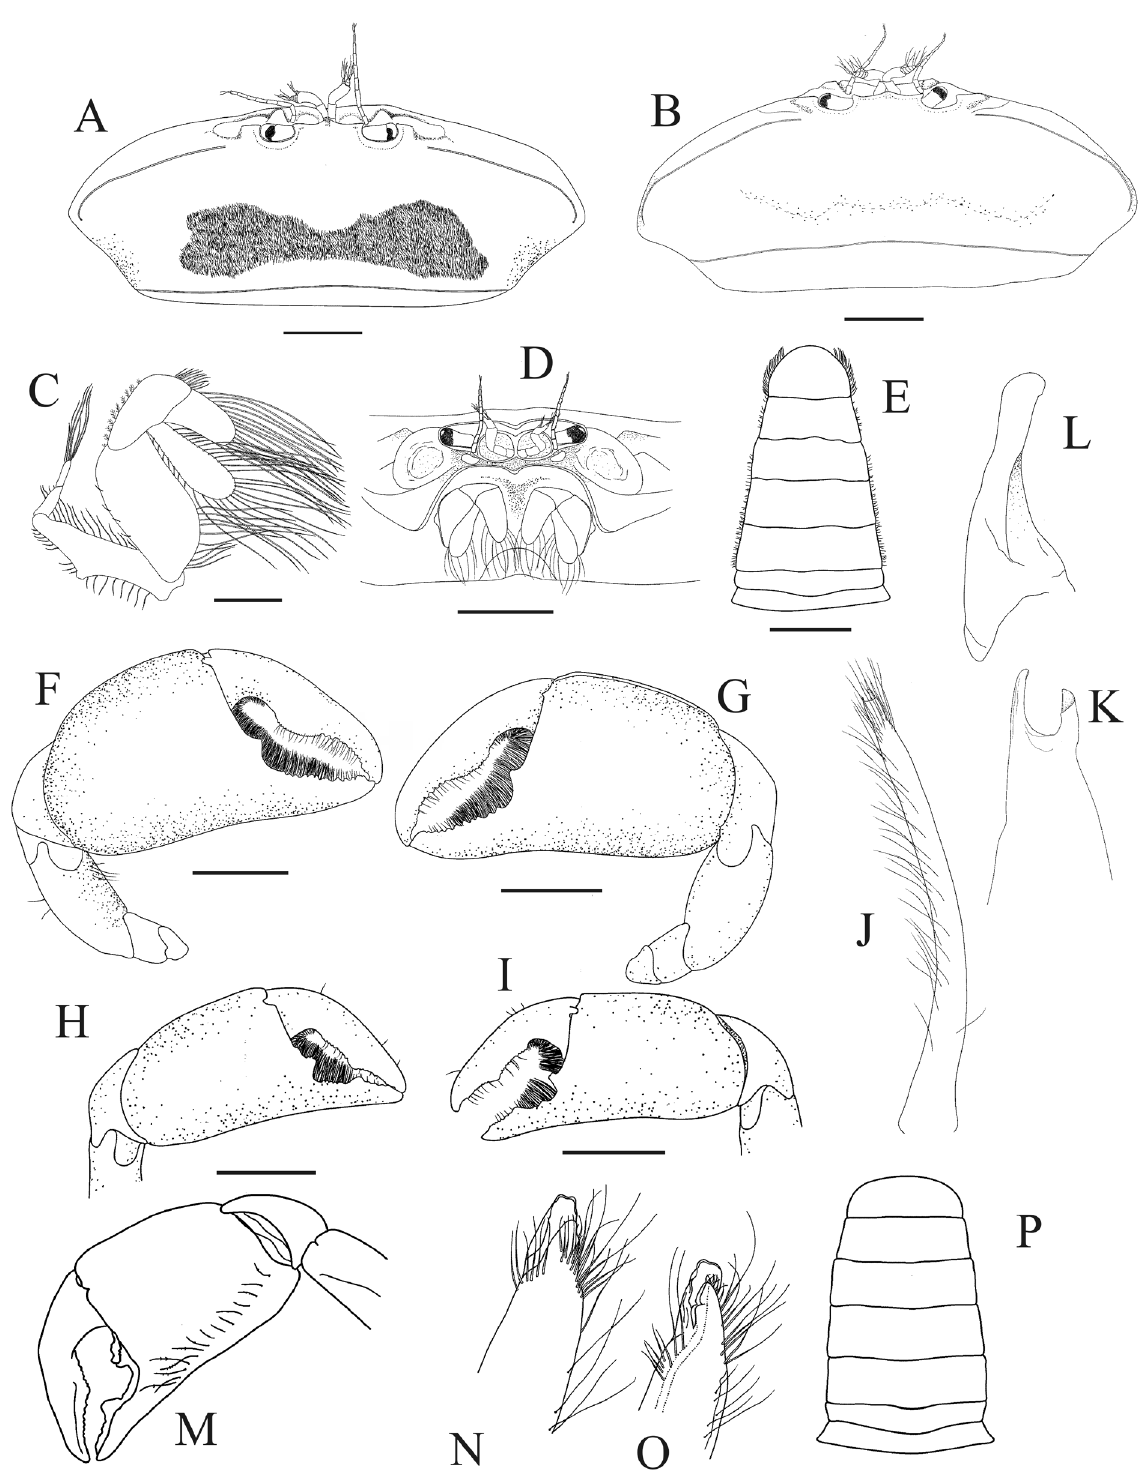
Figure 3. Austinixa marianae n. sp. A, C–G, J–L , male paratype (ICML-EMU 12531); B, H–I , female paratype (ICML-EMU 12531). Austinixa roblesi Palacios Theil and Felder, 2020a, M–P. A , Male carapace, dorsal view; B , female carapace, dorsal view; C , third maxilliped, external view; D , carapace frontal region, anterior view; E , pleon; F , male right cheliped, external view; G , male left cheliped, external view; H , female right cheliped, external view; I , female left cheliped, external view; J , male, first gonopod, in toto ; K , male, first gonopod, distal portion (setae omitted); L , male second gonopod; M , right chela, internal; N , left first gonopod tip, pleonal surface; O , left first gonopod tip, sternal surface; P , male pleon. Scale bar = 1 mm, except C = 0.2 mm. ( M–P